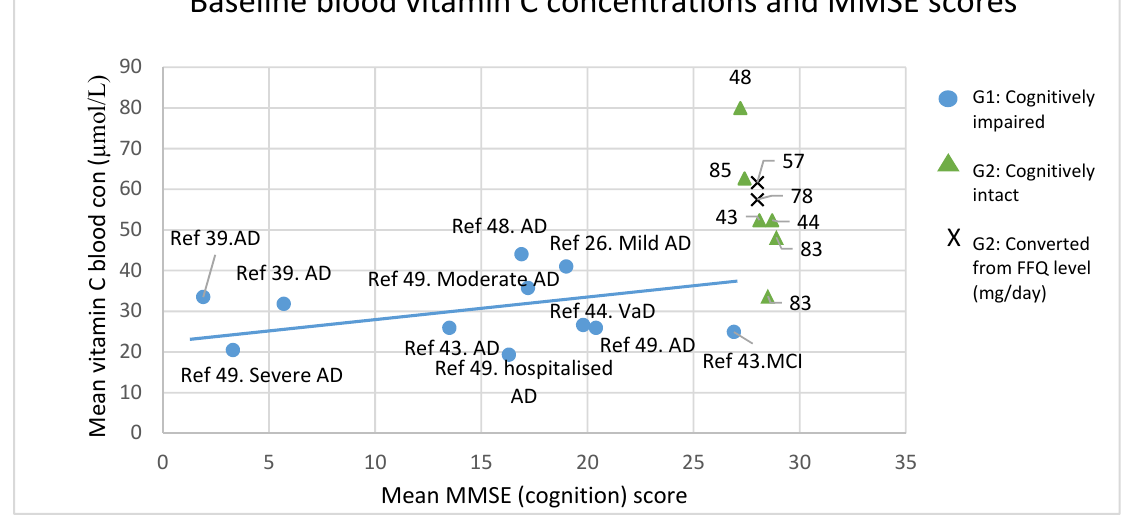
Figure 2. Scatterplot of baseline mean MMSE scores against blood vitamin C concentrations. Blue circles represent cognitively impaired groups of participants, and green triangles and crosses represent cognitively intact groups (triangles: direct plasma vit C measure, cross: converted from FFQ). No correlation analyses were conducted on the cognitively intact data points. The blue line represents the correlation slope amongst the studies of cognitively impaired groups of participants (r s (11) = 0.009, p = 0.98). Key: Ref = study reference, * Not included in the analysis, AD = Alzheimer’s disease, CSF = Cerebral Spinal Fluid, FFQ = Food Frequency Questionnaire; MCI = mild cognitive impairment, mg/day = milligram per day, VaD = Vascular dementia, Con = concentration, MMSE = Mini Mental State Examination.